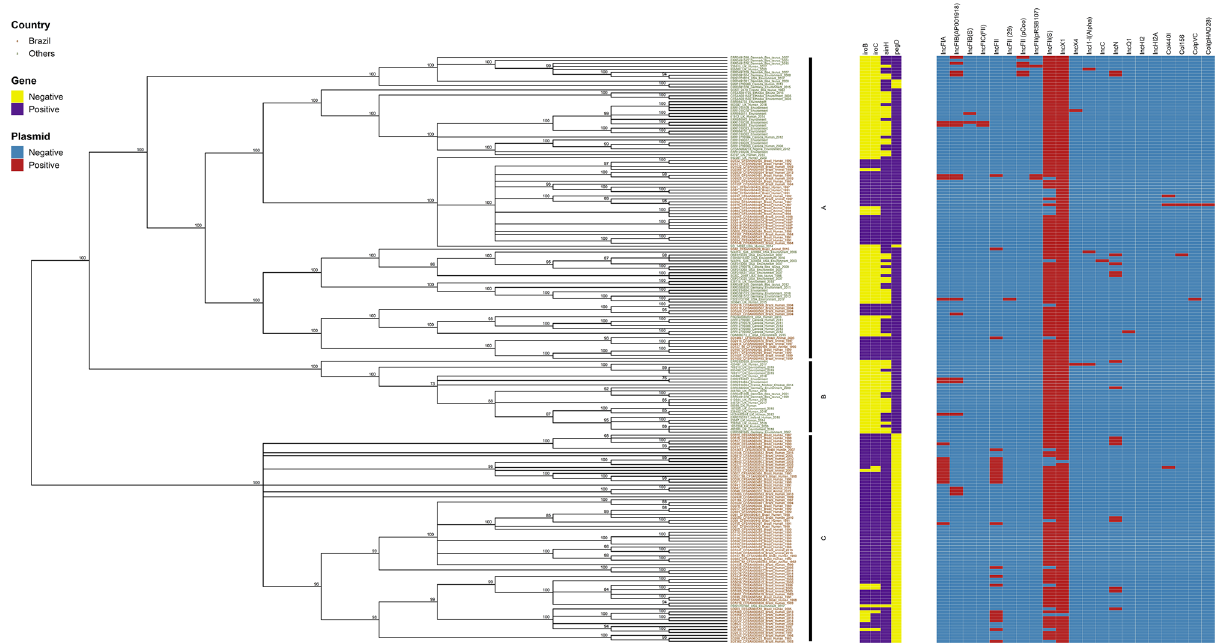
Figure 1. Parsimony tree based on the SNP-analysis of 112 Salmonella enterica serovar Dublin strains isolated in